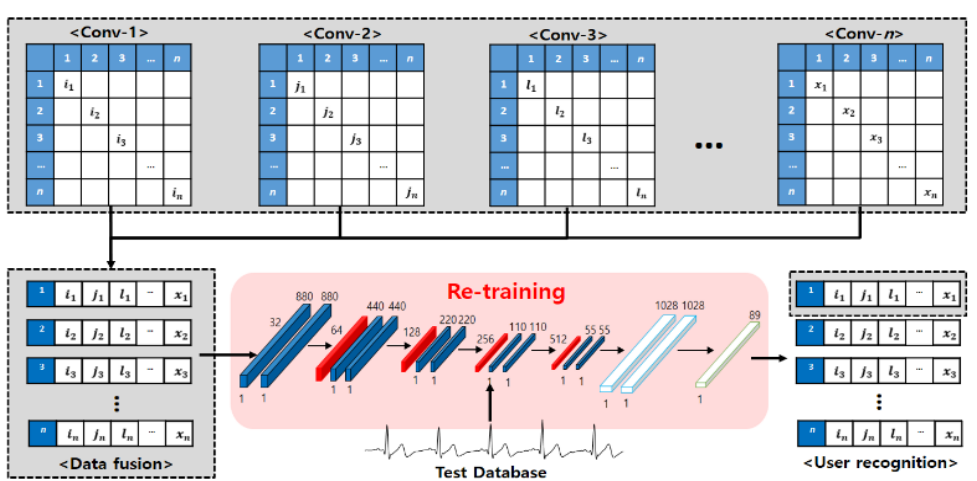
Figure 6. Single network for retraining.